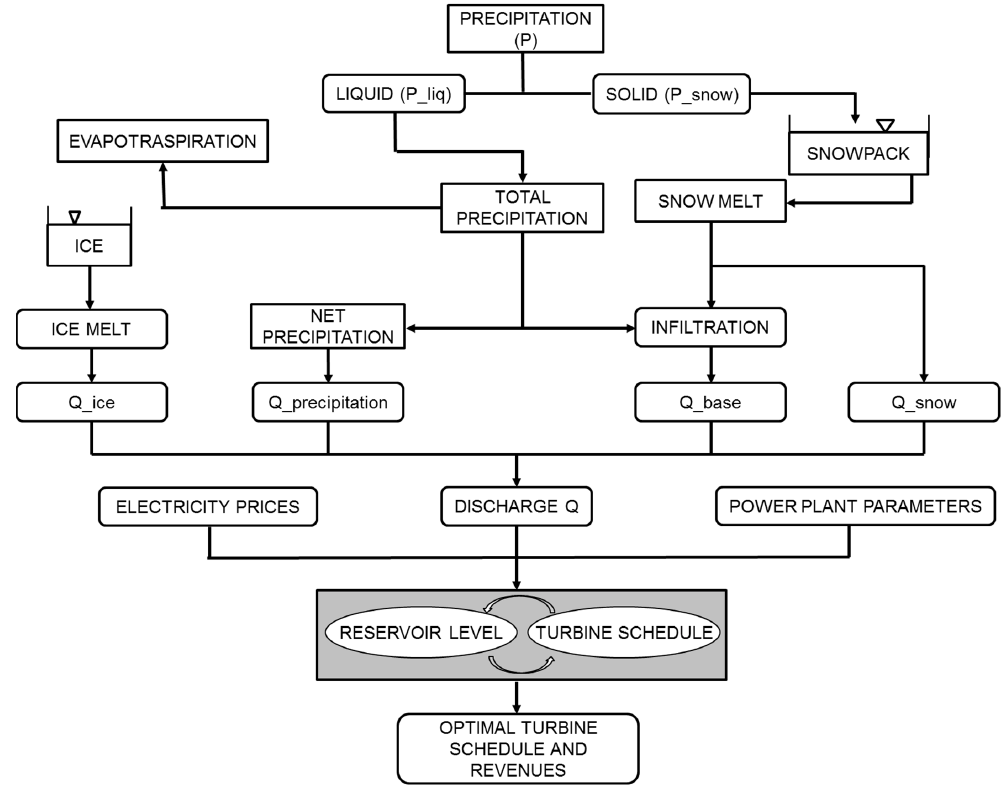
Figure 2. Schematic representation of the hydrological and hydropower management model used. Rosso [92] formula estimated the Nash parameters for the basin response to liquid precipitation.